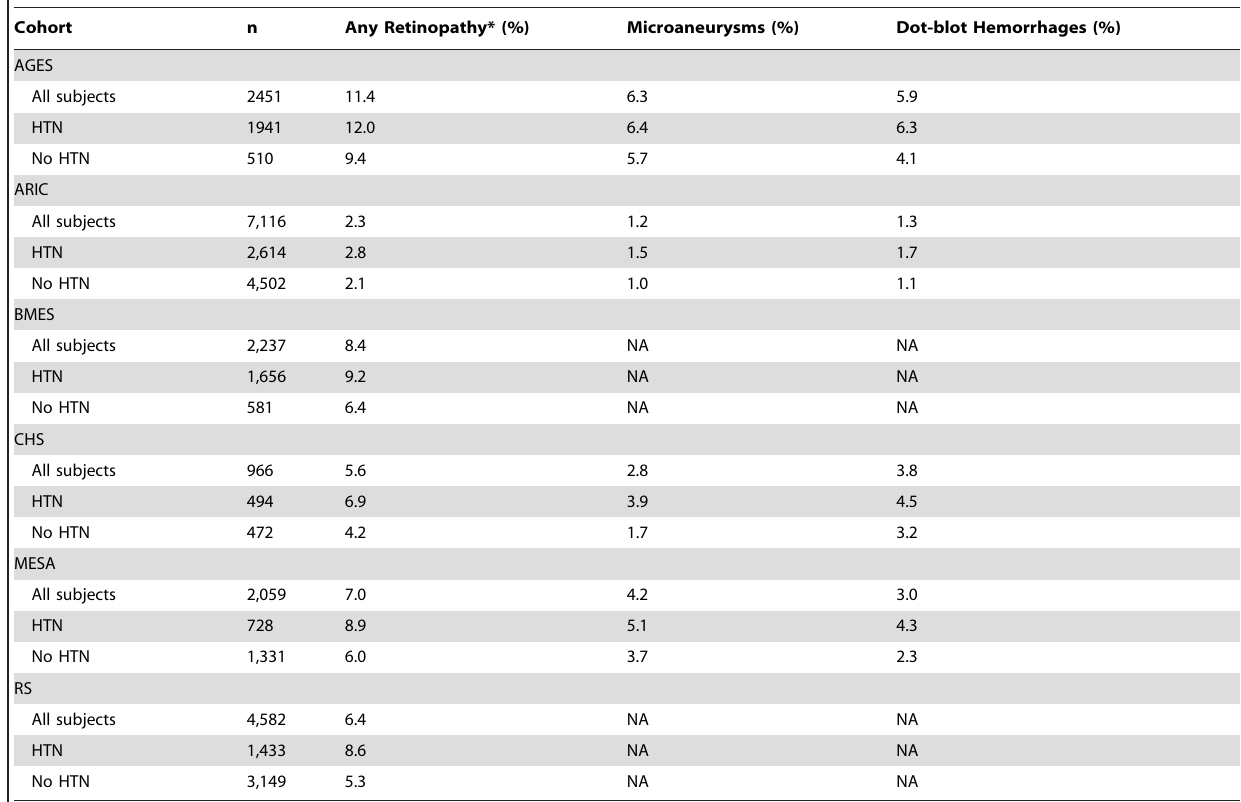
Table 2. Distribution of retinopathy